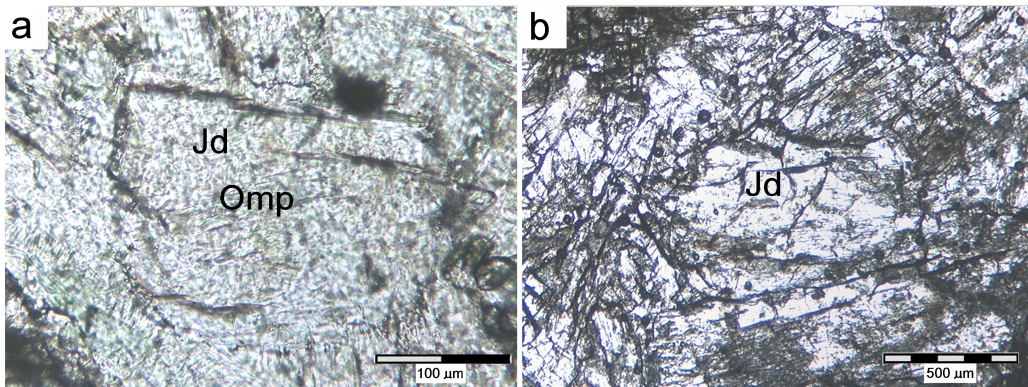
Figure 7. Photomicrographs of jadeitite: (a) jadeite granoblast (Jd), including tiny linear-oriented exsolutions of omphacite (Omp) in the core (3788, plane-polarised light, PPL), and a (b) partly retrogressed jadeite (Jd) matrix, including crumbled crystals (hundreds of micrometres across) intertwined with dusky portions (CMIX/81, PPL).